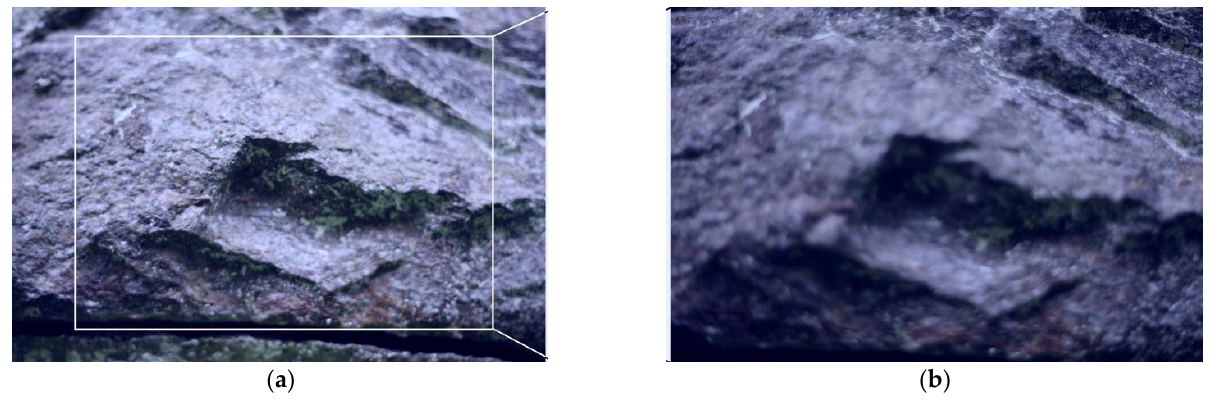
Figure 2. Different scaling and different sharp and non-sharp regions in images acquired by the classic camera positioned at different distances from the 3D relief of the first ( a ) and the sixteenth ( b ) image of a series of sixteen images, blue marble, locality (Nedvedice, Czech Republic, photo Pavel Starha). Taken from [26].